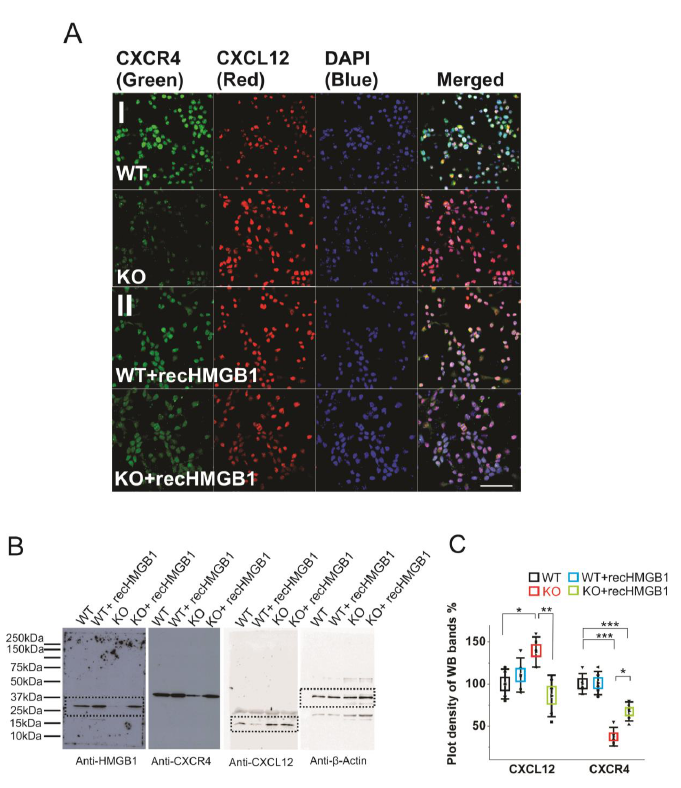
Figure 5. Expression of CXCR4 and CXCL12 in cultured HMGB1 KO and WT brain cells. Cells from cortical cultures of five KO and WT E16 brains were collected and cultured for immunostaining and Western blotting analysis. ( A ) Anti-CXCR4 and Anti-CXCL12 staining of E16 cortical neurons cultured for two days. (I) WT and HMGB1 KO cortical neuronal cells. (II) Cultures with added recombinant HMGB1 (recHMGB1;10 μg. Scale bars indicate 50 μm. All images are confocal z-stack max projections of 10 μm. ( B ) Western blotting of E16 neuronal cell samples cultured for two days. The same sample has been used for all four antibodies in the Western blotting experiment. On lanes with multiple bands the relevant areas have been encircled with rectangles. ( C ) Plot-density analysis of Western blotting bands of the cultured cell samples. Three repeats were applied with the cell samples collected from five KO and five WT brains. CXCL12 in the KO is significantly higher than in the other groups. CXCR4 in the KO and in the KO + recHMGB1 is significantly lower than in the WT, but CXCR4 in the KO + recHMGB1 is significantly higher than in the KO. Mean values ± S.D. (error bars) and SEM (boxes) are indicated ( n = 5; *** p < 0.001; ** p < 0.01; * p < 0.05, unpaired t -test, two- tailed).